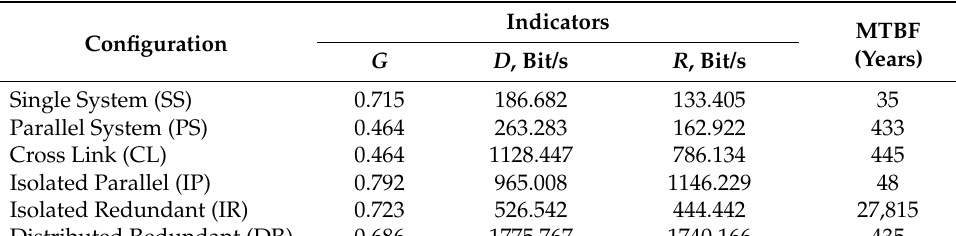
Table 4. Information indicators of PSS’s configuration.